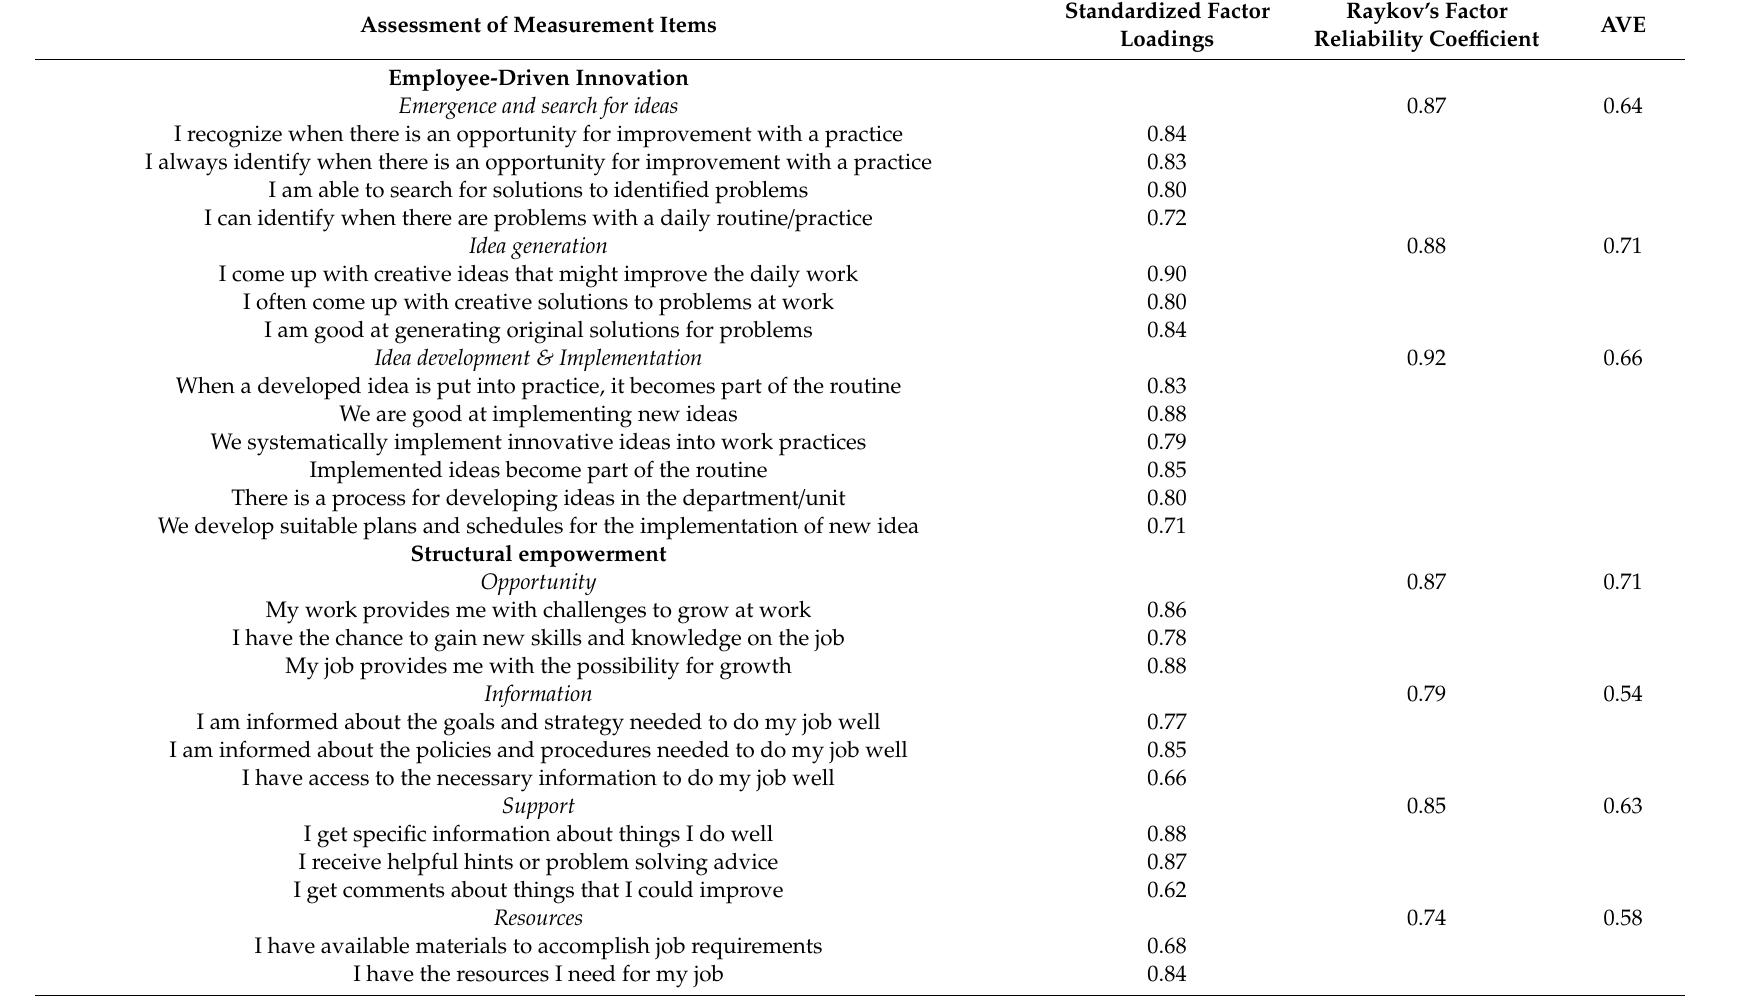
Table 2. Items and Confirmatory Factor Analysis